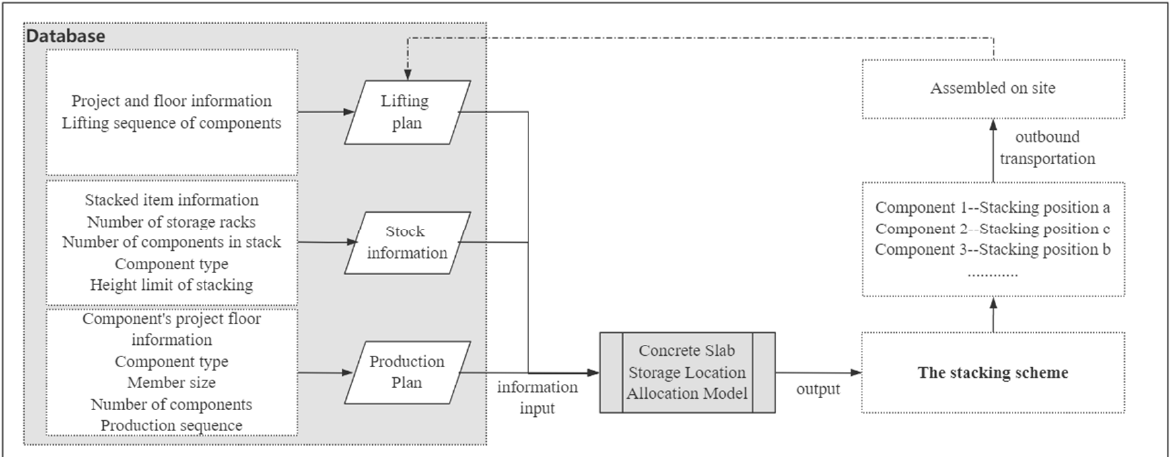
Figure 2. Framework flow chart for allocation of component storage locations.